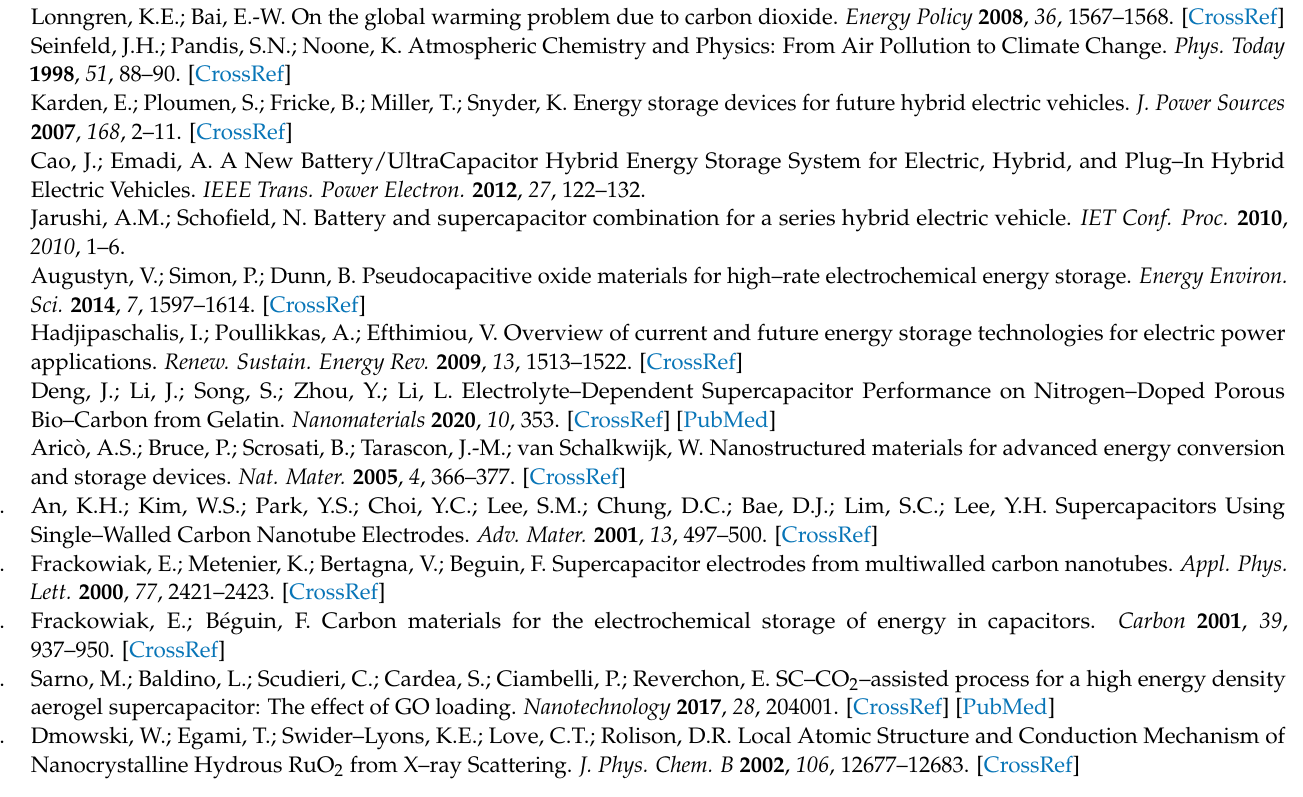
Figure S2: FE–SEM images with histograms of diagonal size distribution of (a) Co2P2O7/CNFs@400, (b) Co2P2O7/CNFs@600 and (c) Co2P2O7/CNFs@800, Table S1: Values of fitting parameters obtained from the EIS